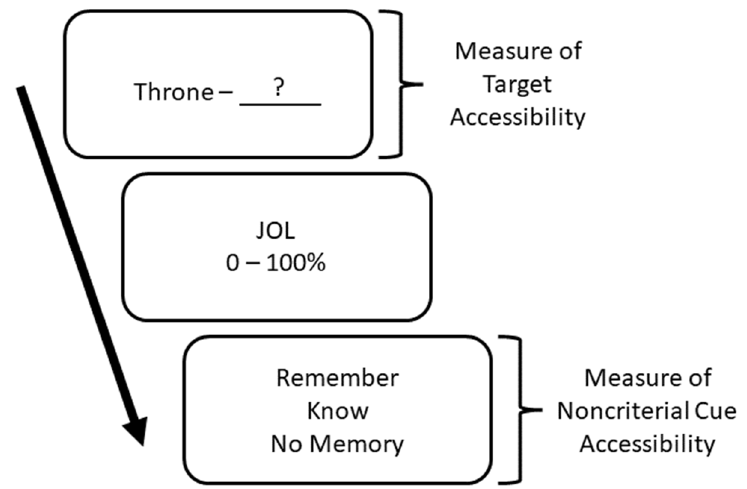
Figure 2. Depiction of the JOL Phase. For each word pair, participants made a cued-recall attempt, a JOL, and a remember/know/no memory response. Participants completed each of these three tasks before proceeding to the next word pair.